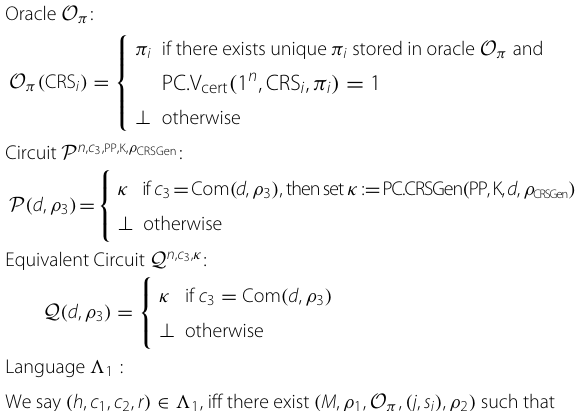
Table 1 The languages used in